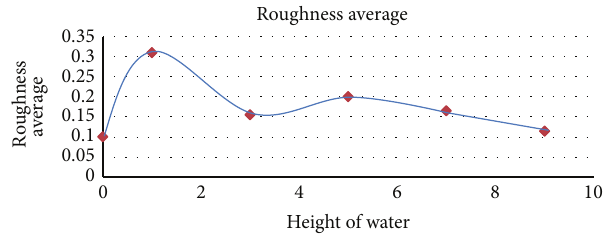
Figure 7: Surface roughness of treated region with different thick- nesses of water layer.